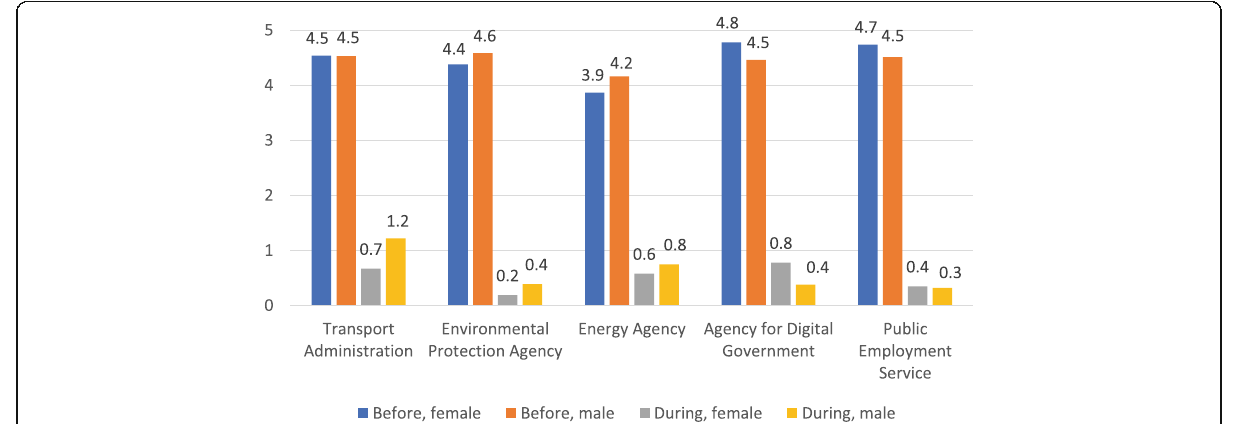
Fig. 1 Average commuting days per week. Responses to the Question ‘ How Many Days Per Week Did You Travel to Work Before, and How